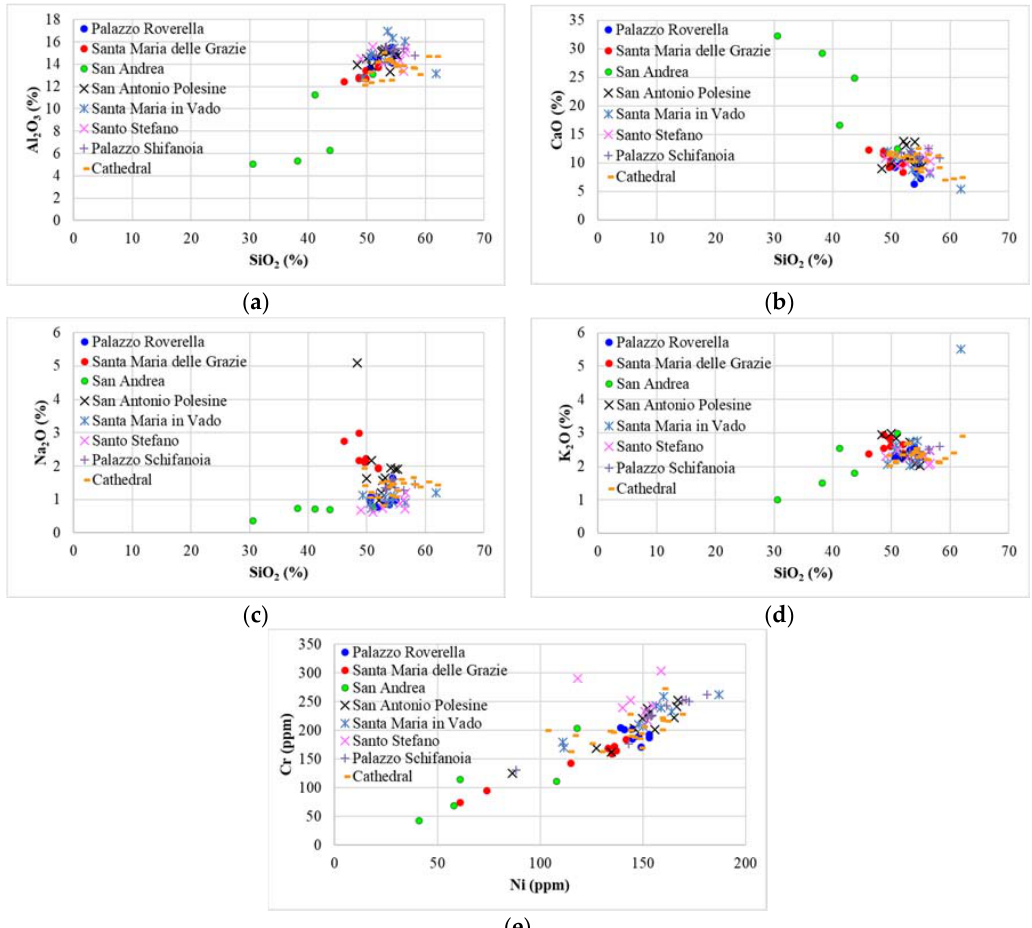
Figure 8. Binary diagrams on the XRF data compared to the data of other important historical buildings located in the city center of Ferrara [55]: ( a ) Al 2 O 3 -SiO 2 ; ( b ) CaO-SiO 2 ; ( c ) Na 2 O-SiO 2 ; ( d ) K 2 O-SiO 2 ; ( e ) Ni-Cr.